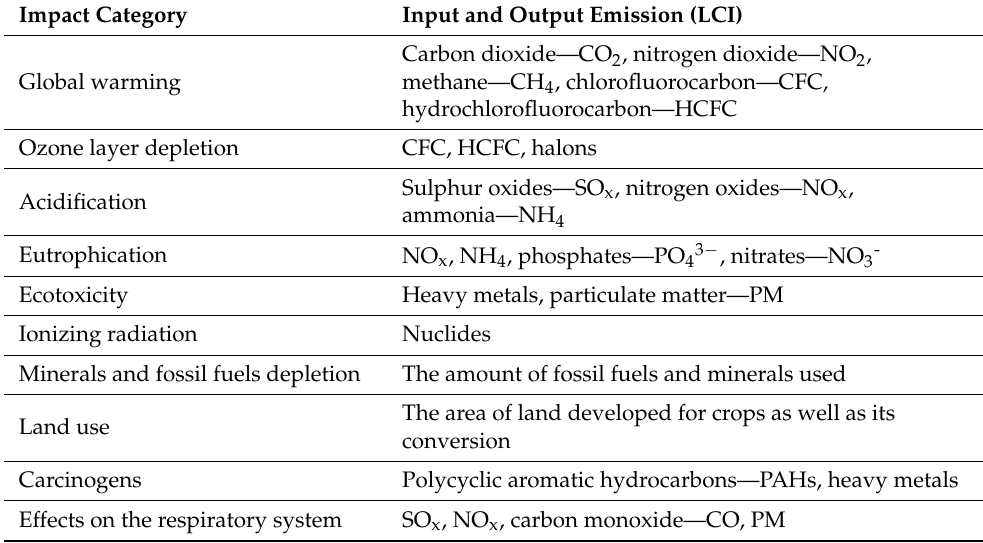
Table 1. Impact categories available in the frame of the Eco-Indicator 99 method. Impact